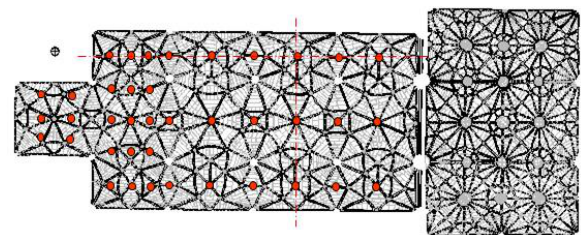
Figure 3. Photogrammetry of the vaults of the church of Jeróniimos monastery in Lisbon. (nave and transept). Location of the photos taken in the nave (Genin,